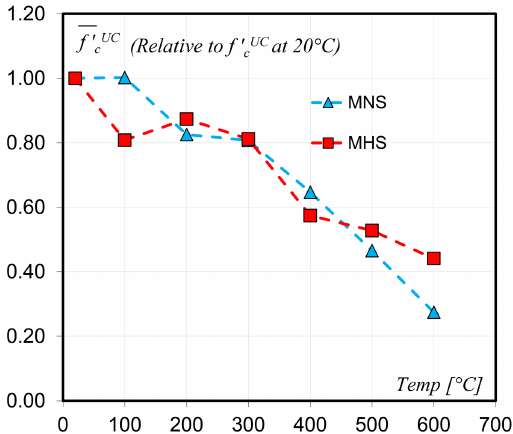
Figure 9. Evolution of compressive strength with temperature. Relative values to the reference compressive strength at 20 ◦